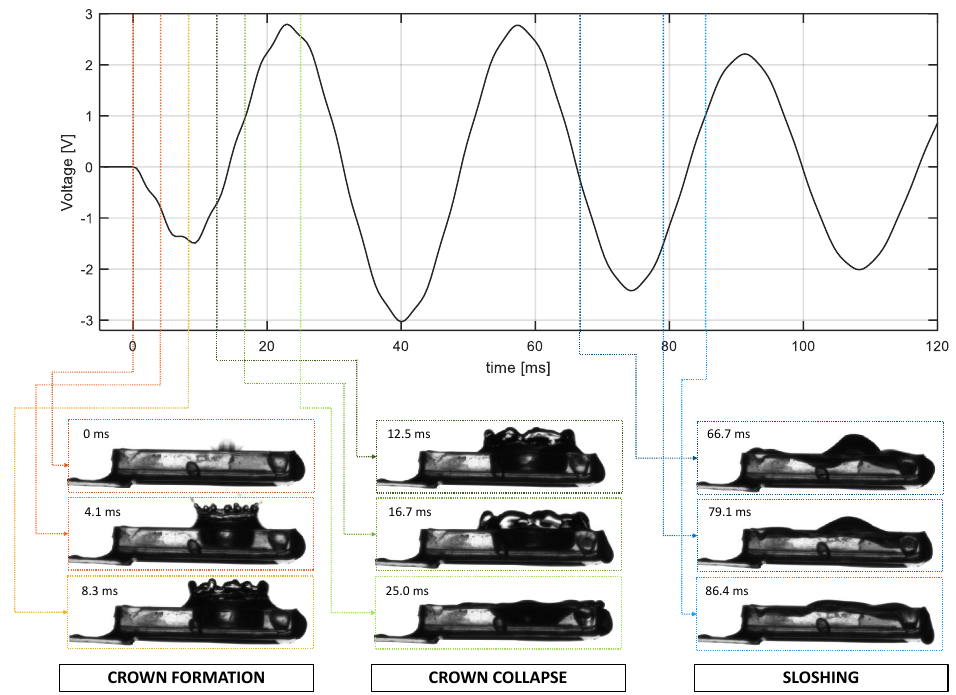
Figure 9. Drop impact on a full spoon. Time evolution of voltage and camera pictures at selected instants, showing the main phases of water